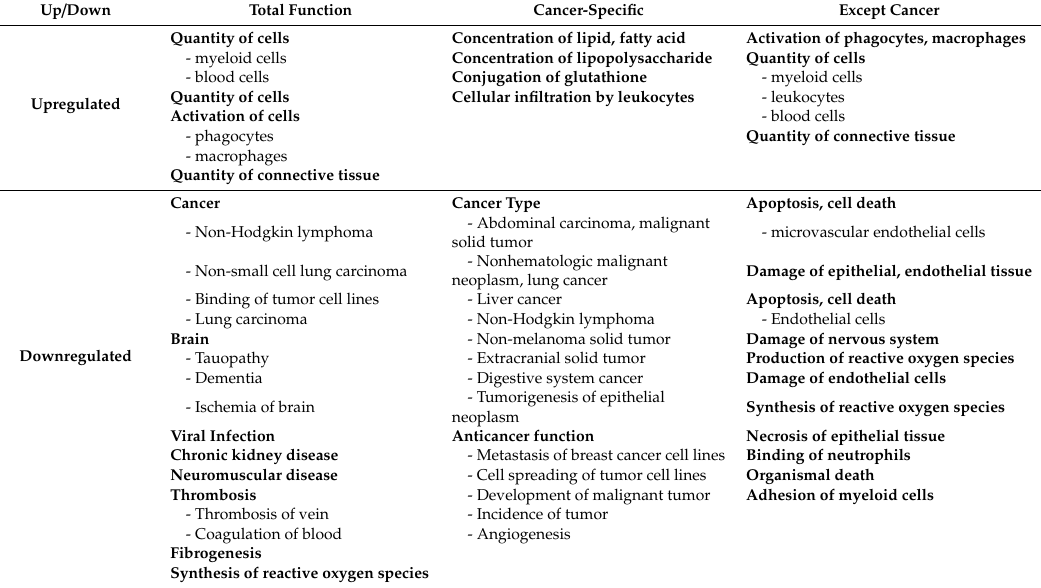
Figure 1. A representative example of the analysis for fractionated serum protein digest by liquid chromatography with tandem mass spectrometry (LC-MS/MS). ( a ) Base peak chromatogram based on total ion chromatography, the peptides indicate identified peptides of SPA3N. ( b ) The sequence of SPA3N, the peptides in the red boxes indicate peptides found by MS/MS. ( c ) The experimental MS/MS spectrum for the SPA3N doubly charged tryptic peptide sequence AKALYQAEAFTADFQQSR among the identified peptides by matching a peptide fragmentation pattern. Table 2. Identified possible functions of NFP in the serum of the rat treated with NFP by Ingenuity Pathway Analysis